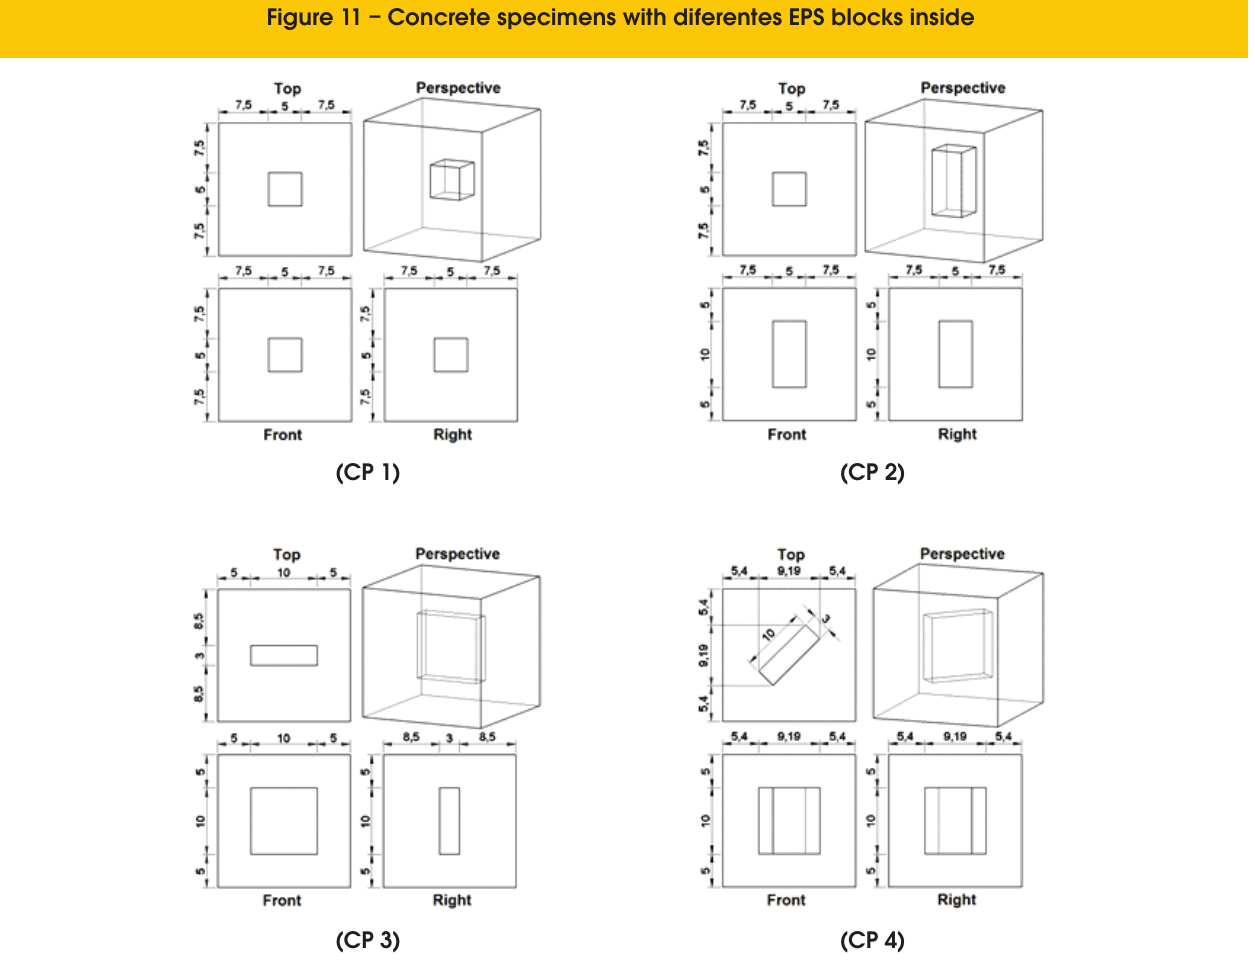
Figure 11 – Concrete specimens with diferentes EPS blocks